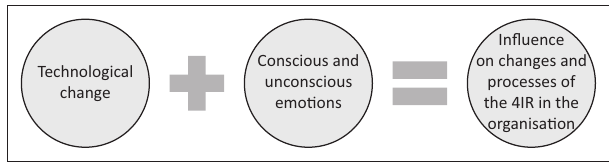
FIGURE 1: Technological change and